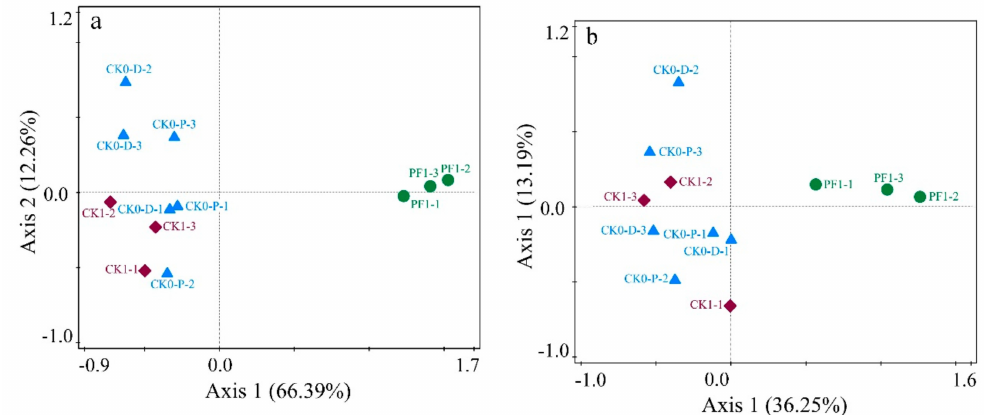
Figure 2. Principal component analysis (PCA) of soil ( a ) bacteria and ( b ) fungi at the genus level in the dryland-to-paddy conversion process. CK0-D is the soil sample before CK1 pot experiment, CK0-P is the soil sample before PF1 pot experiment, CK1 is the soil sample before corn harvest, and PF1 is the soil sample before rice harvest.